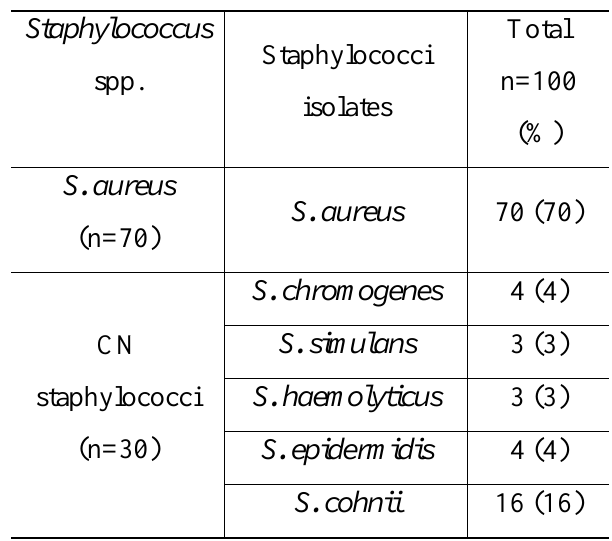
Table 2. Staphylococcus spp. isolates detected based on coagulase testing, API kits, and coa